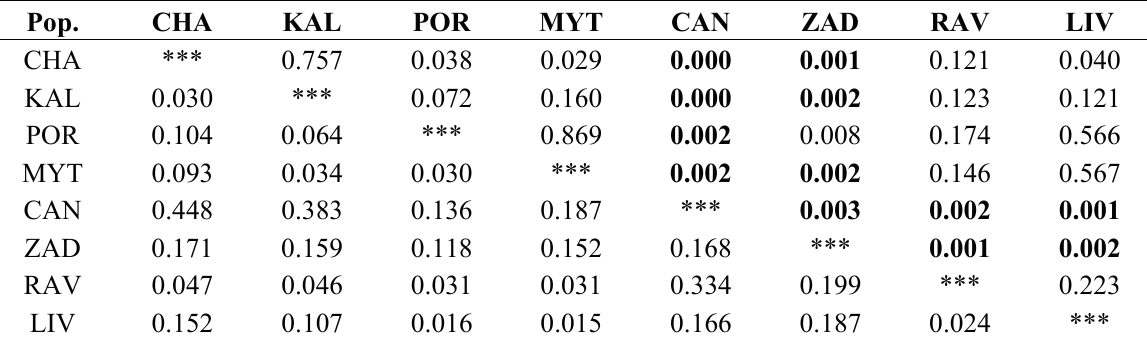
Table 3. Pairwise differentiation Φ Significant p values after sequential Bonferroni correction for α = 0.05 are shown in bold ( p ≤ 0.0031).